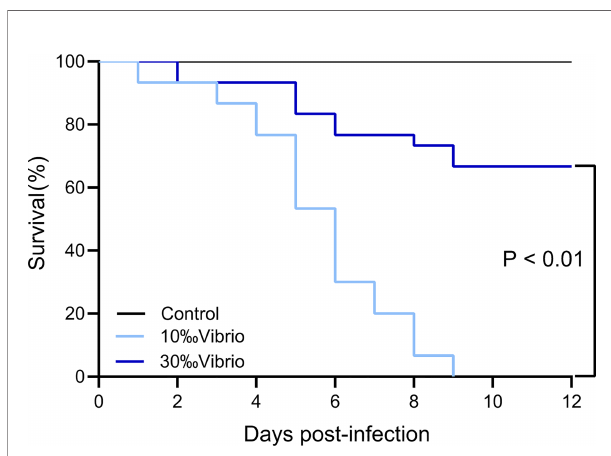
FIGURE 1 | Survival analysis of C. gigas infected with V. alginolyticus at different levels of salinity. The mortality of C. gigas in each salinity group (in triplicate) was monitored for 12days post infection with V. alginolyticus . P < 0.01, log rank test; n =